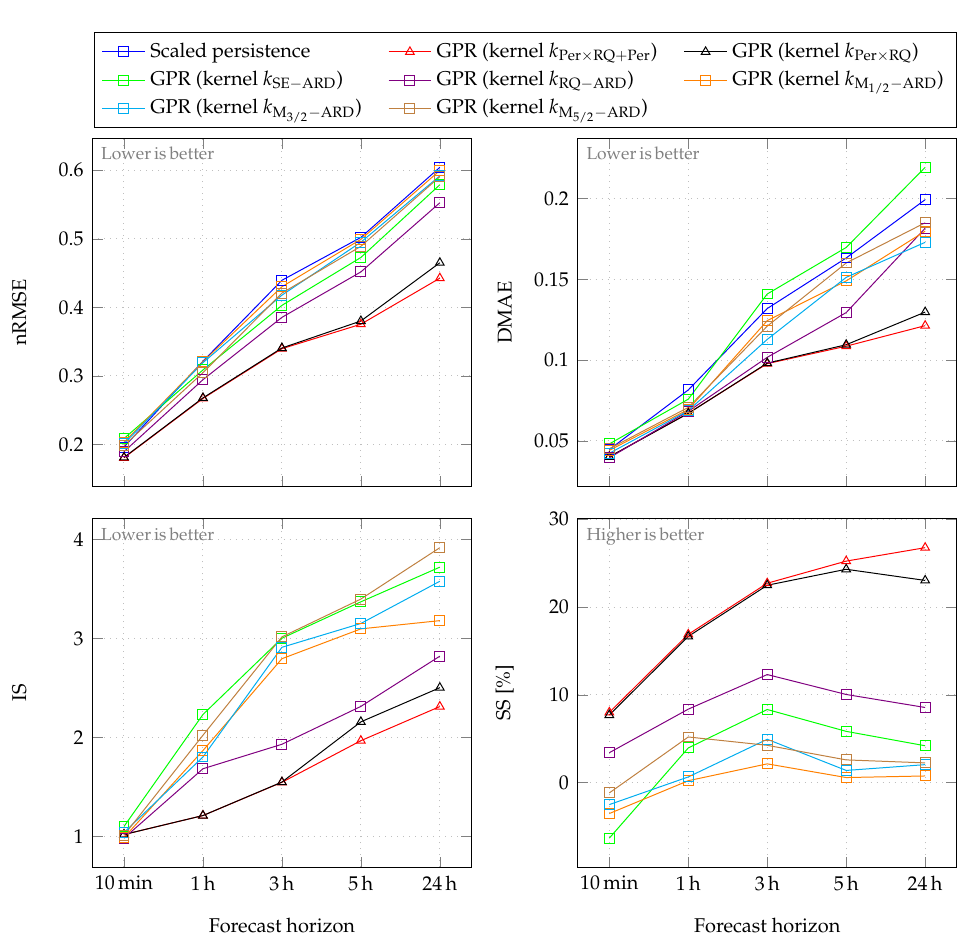
Figure 8. Comparison between multi-horizon GPR models: performance criteria values for time- based (with triangular marks) and observation-based (with square marks) models. Note that the latter are obtained by iterating one-step-ahead models until the desired forecast horizon is reached. Values are calculated using test data (year